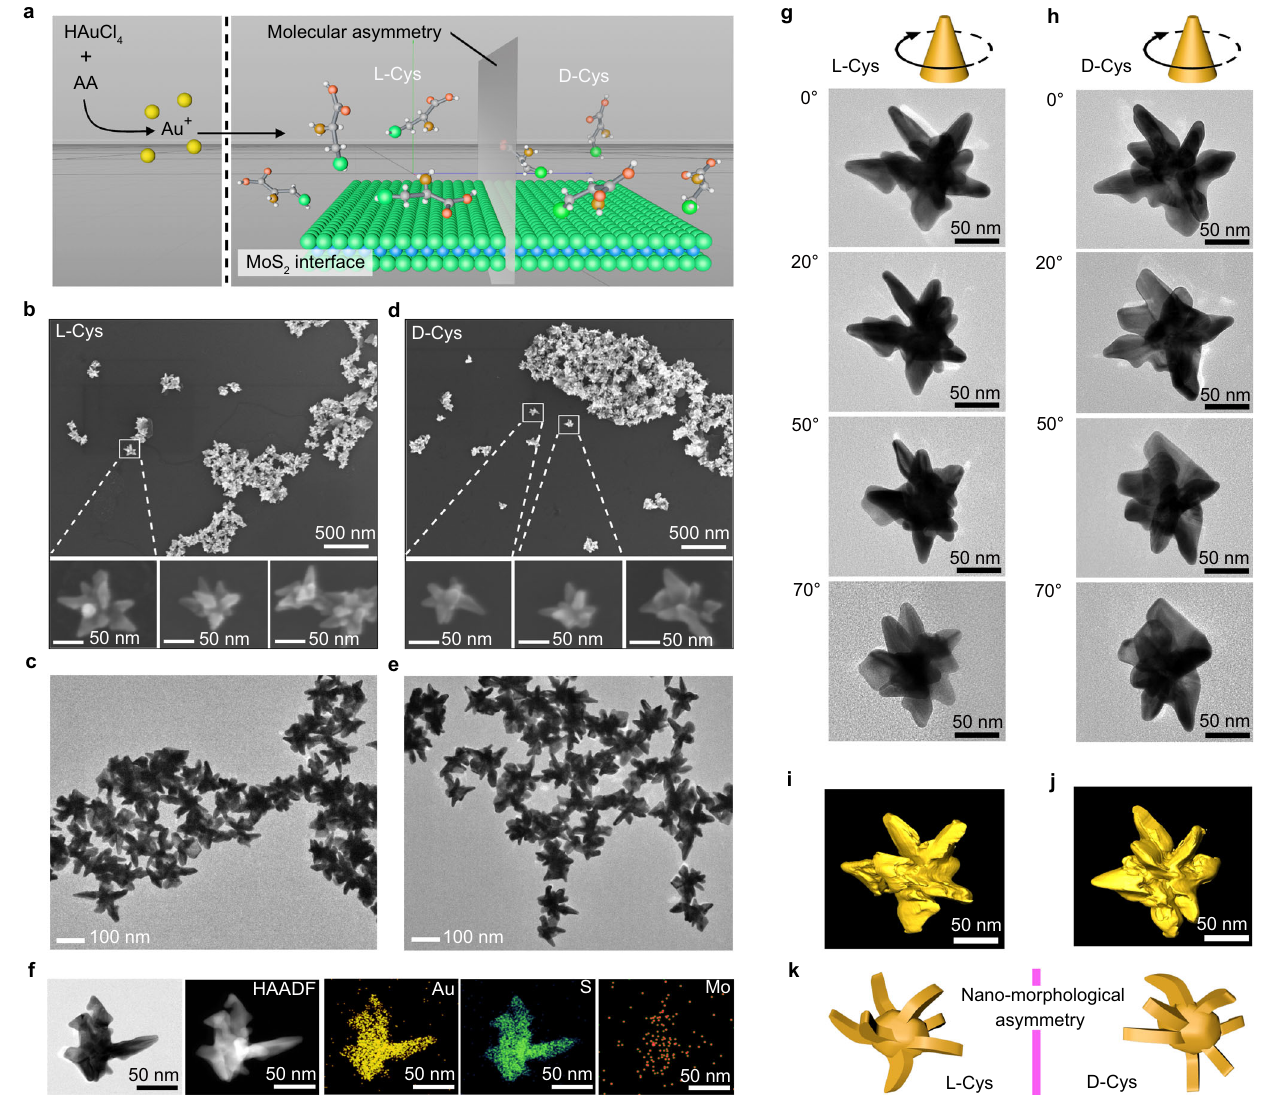
Fig.2|Transferofchiralityfromaminoacidstogoldnanocrystals.a Schematic illustration of cysteine enantiomer-mediated growth of Au nanocrystals in the presence of exfoliated MoS 2 nanosheets; Mo and S atoms are shown as blue and greenspheres,respectively. b – e SEM( b , d )andTEM( c , e )imagesofas-synthesized Au/MoS 2 nanostructures derived from 1.6 μ M L-Cys ( b , c ) and D-Cys ( d , e ), respectively. f TEM, HAADF, and EDX element scan results of L-Cys-endowed